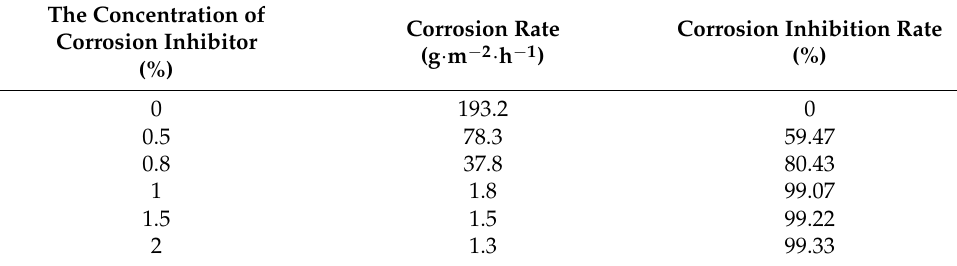
Table 3. The influence of corrosion inhibitor concentration on the corrosion rate. The Concentration